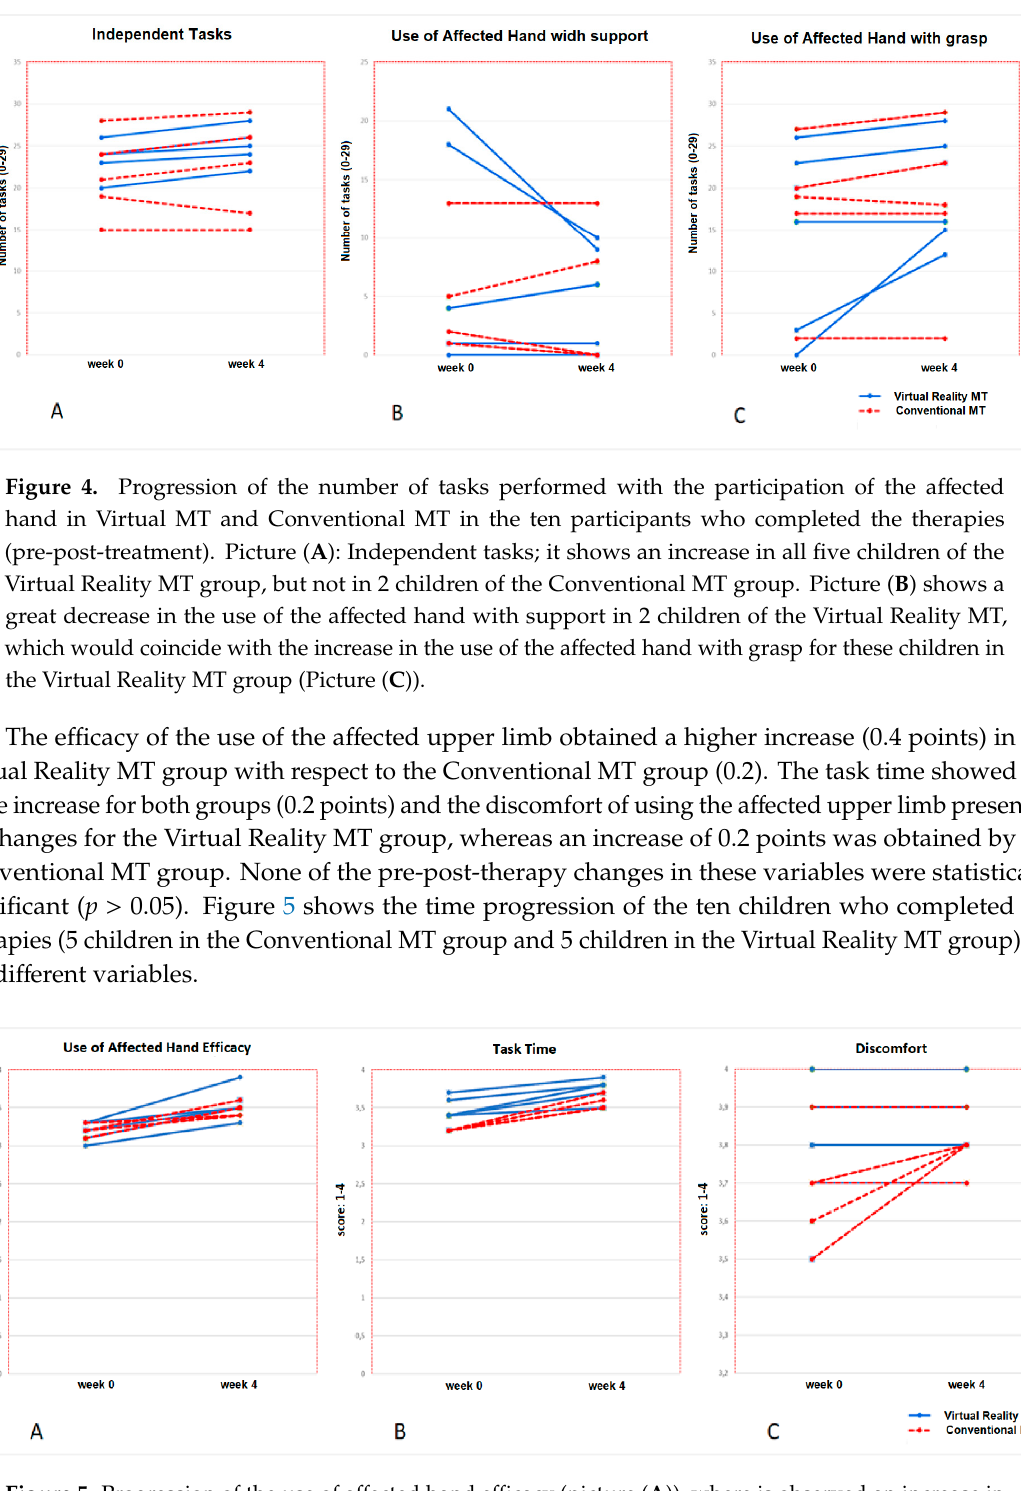
Figure 5. Progression of the use of affected hand efficacy (picture ( A )), where is observed an increase in all ten children in Virtual Reality MT and Conventional MT and the task time had a similar evolution (picture ( B )). the score of discomfort does not vary in the five children of the Virtual Reality MT, and a low increase is observed in 3 children of Conventional MT (picture ( C )).